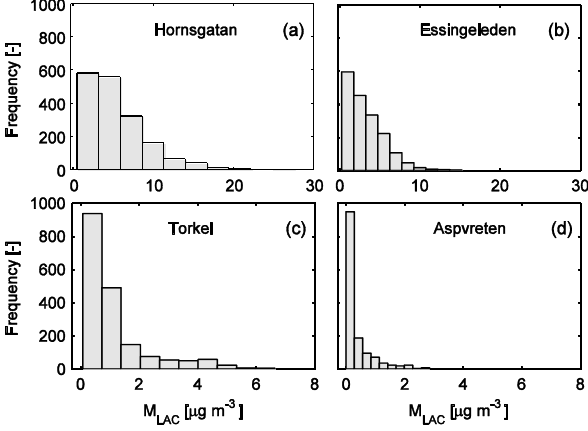
Fig. 4 Fig. 4. Frequency-of-occurrence histograms of hourly M LAC time series at the four sites in the period 20 April–5 July 2006. 1.8 m s − 1 and the dominant winds were from south (22 %), southeast (20 %), and east (15